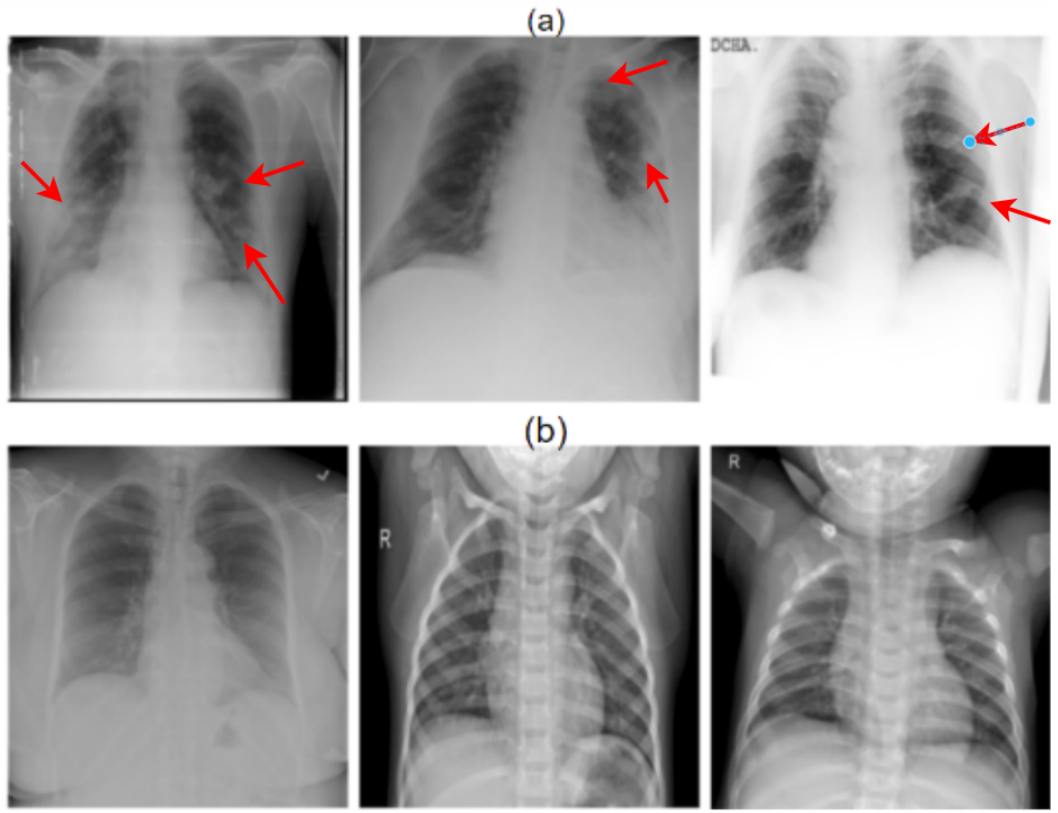
Figure 1. Instances of image data for the two classes of COVID and normal images. Here, ( a ) repre- sents COVID cases and ( b ) depicts normal cases. Here, the red markers indicates the infected